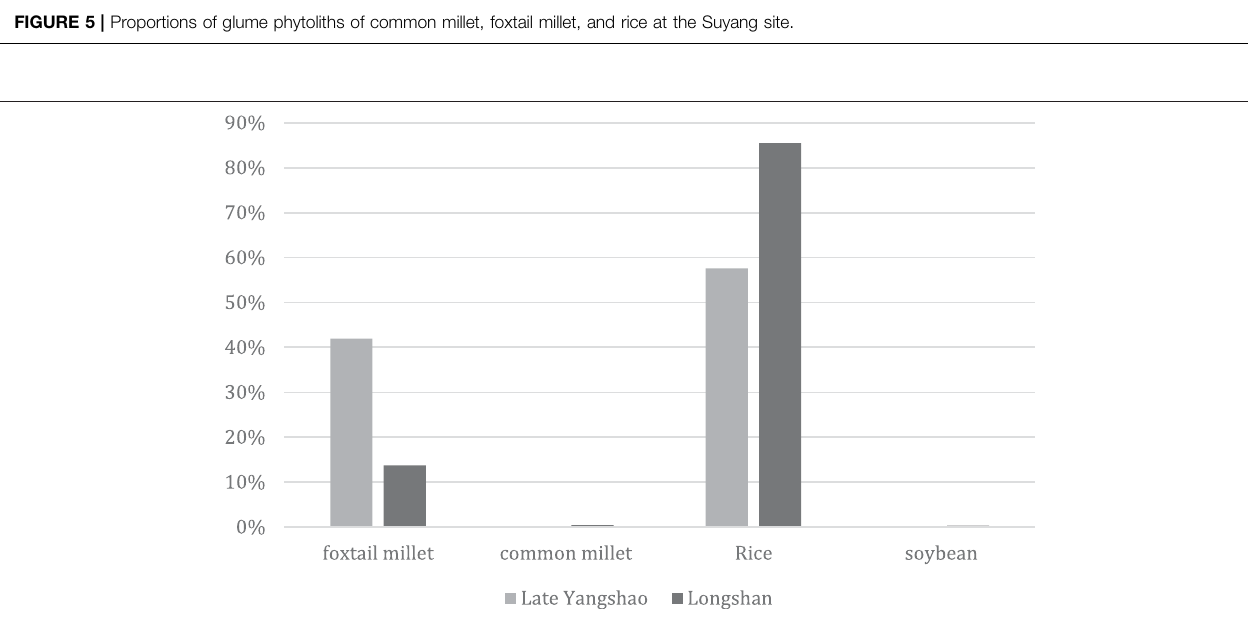
FIGURE 6 | Proportions of crops in different periods in grain weight at the Suyang site.